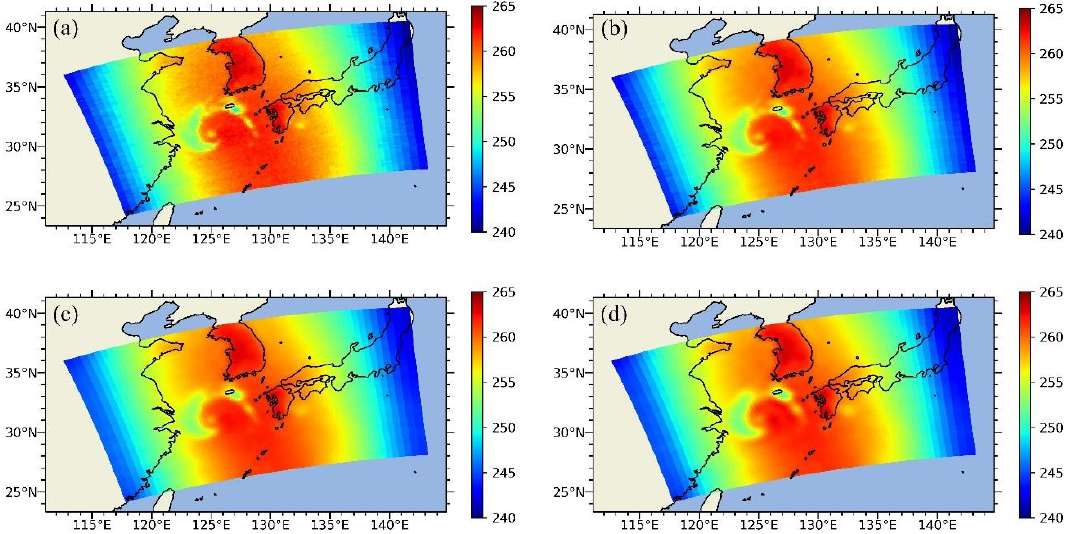
Figure 12. ATMS channel 6 brightness temperature ( a ) without resampling, ( b ) resampled by BGI, ( c ) resampled by AAPP, and ( d ) resampled by modified AAPP. The unit of brightness temperature is K.